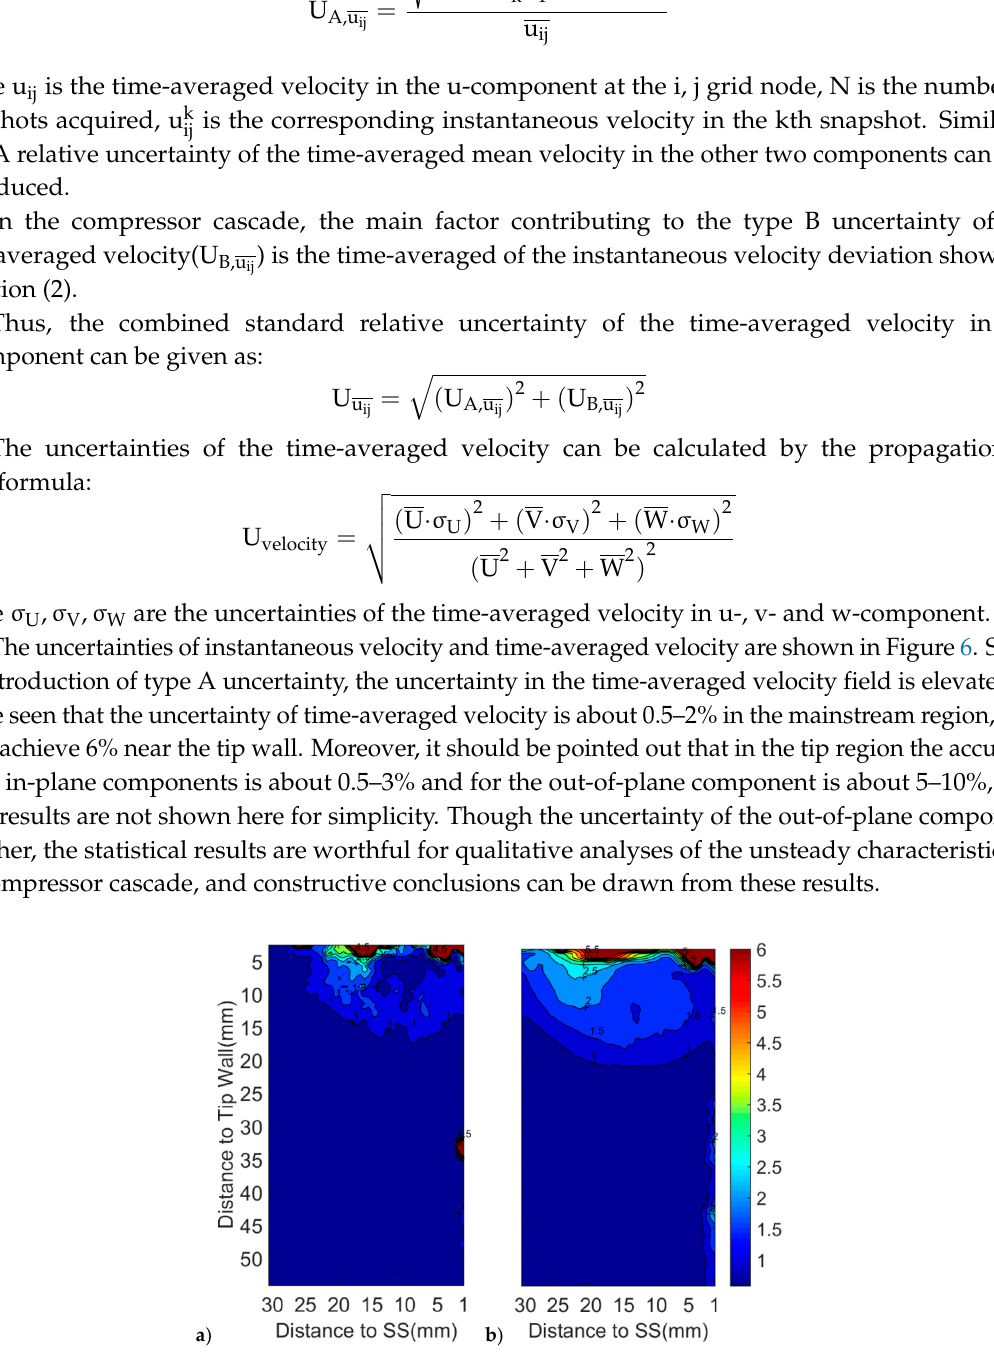
Figure 6. Distribution of measurement relative uncertainties in percentage terms at L/c = 1.0, ( a ) the instantaneous velocity, ( b ) the time-averaged velocity. The velocity is the resultant velocity of components in the x-, y- and z-